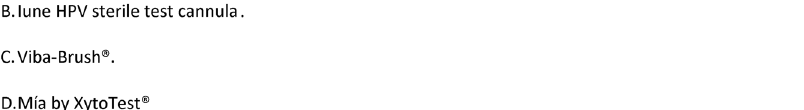
Figure 1. Self-sampling devices included in the